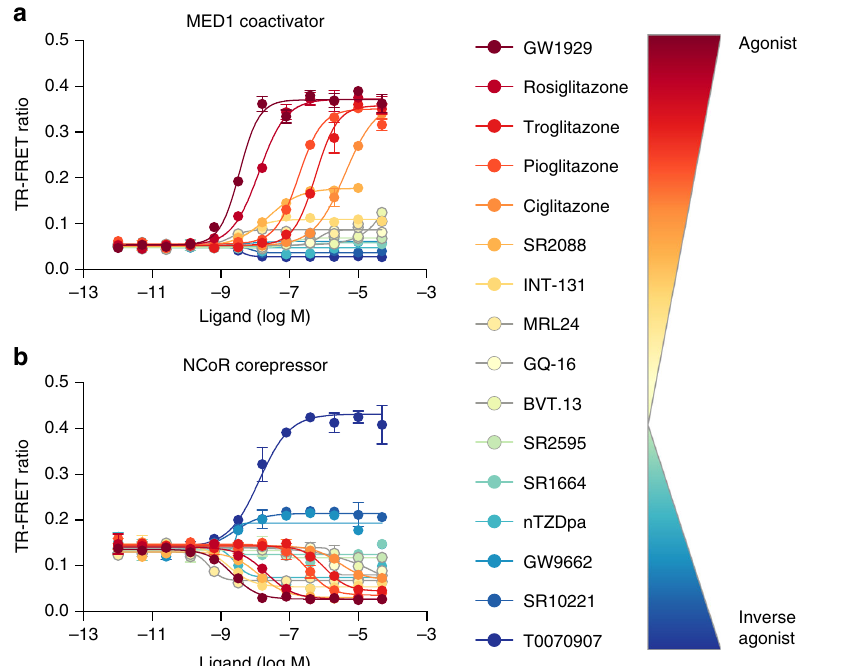
Fig. 1 Nuclear receptor co-regulator interaction differentiates pharmacologically distinct PPAR γ ligands. TR-FRET biochemical assay shows the effect of the compounds on the interaction between PPAR γ LBD and peptides derived from the a MED1 coactivator and b NCoR corepressor, plotted as TR-FRET ratio (665 nm/620 nm) vs. ligand concentration ( n = 2, standard deviation). The data shown represents technical replicates from a single experiment and the experiment was repeated four times with similar results. The window of ef fi cacy in these data is representative of ligand-induced changes in co-regulator af fi nity for PPAR γ . An increase in TR-FRET ratio indicates a strengthening of af fi nity for MED1/NCoR compared to apo while a decrease indicates a ligand- induced weakening of af fi nity for the co-regulator. The effect of vehicle (DMSO) is negligible (Supplementary Fig. 5); furthermore, the DMSO concentration is constant across the titration both in this fi gure and all other TR-FRET data